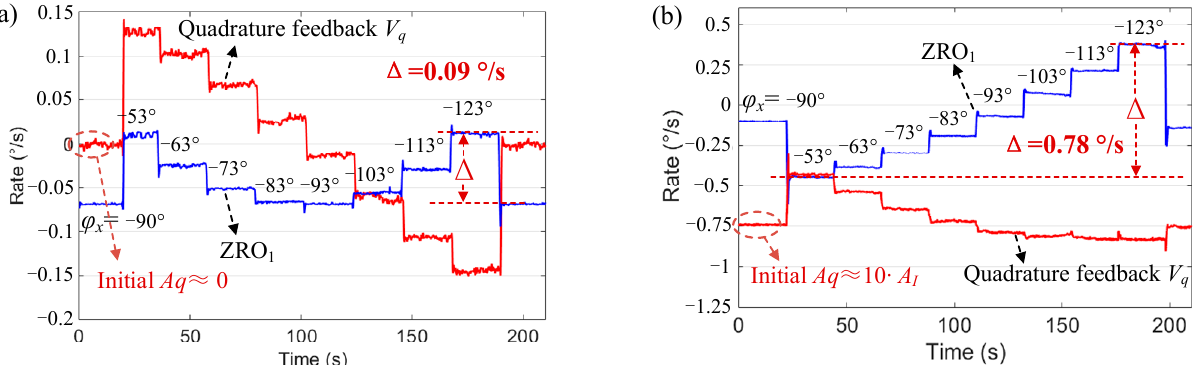
Figure 9. ZRO 1 at different ϕ x in Mode I. ( a ) The initial quadrature error is adjusted to 0 and ( b ) the initial quadrature error is not 0.